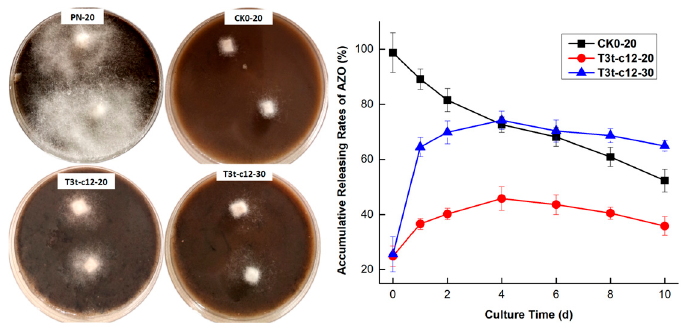
Figure 10. Mycelium of Phytophthora nicotiana PNgz07 on Tab-5 agar and accumulative release rate of AZO. Plate labeled PN-20 contained no AZO within the agar and was cultured at 20 °C (negative control); plates CK0-20 and T3t-c12-20 contained CK0 or T3t-c12 AZO-loaded NPs within the agar and were cultured at 20 °C; T3t-c12-30 contained the T3t-c12 AZO-loaded NPs within the agar and was cultured at 30 °C.